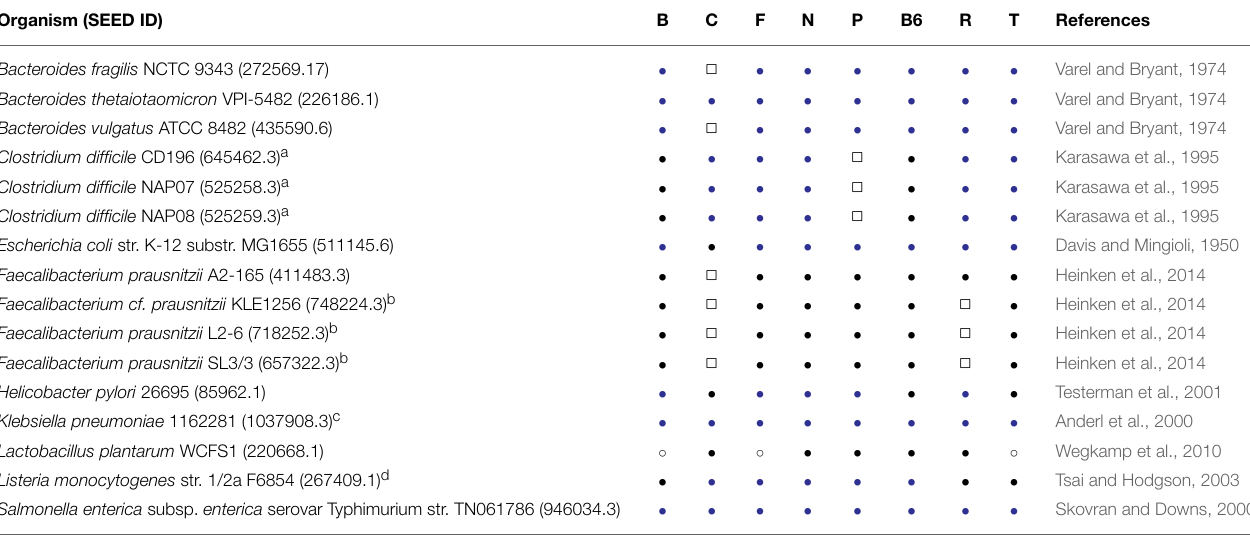
TABLE 4 | Comparison of genomic predictions and experimental